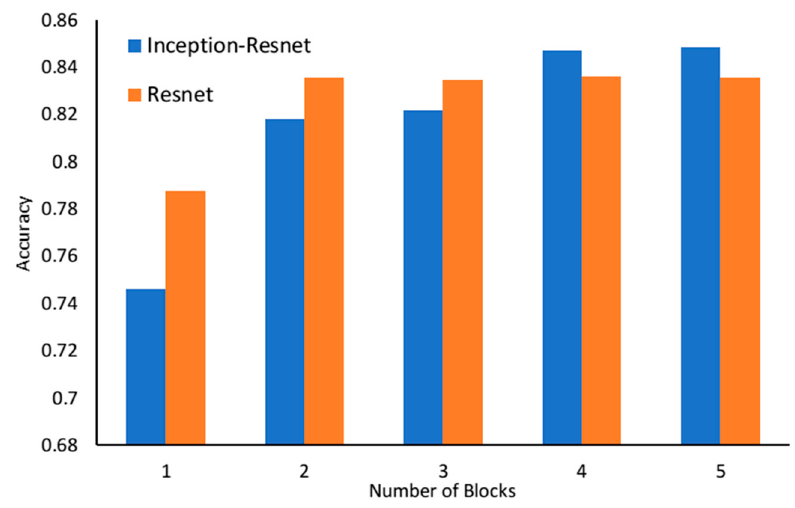
Figure 7. An accuracy comparison between the model with Inception-Resnet blocks and the model with Resnet blocks.